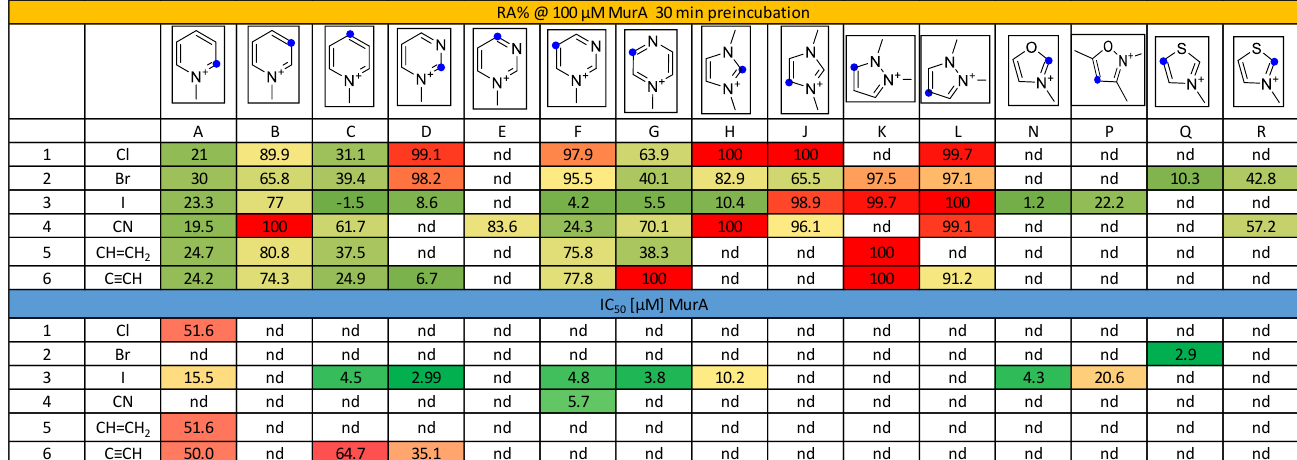
Table 1. Comparison of the most active methylated heterocycles with their first-generation matched pairs.